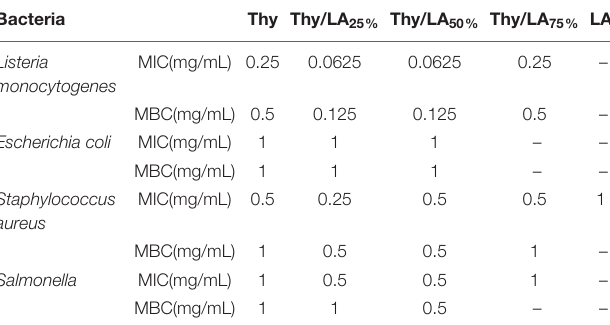
TABLE 1 | The minimum inhibitory concentration (MIC) and minimum bactericidal concentration (MBC) of different mass thymol/lauric acid ratios against four foodborne pathogens n =